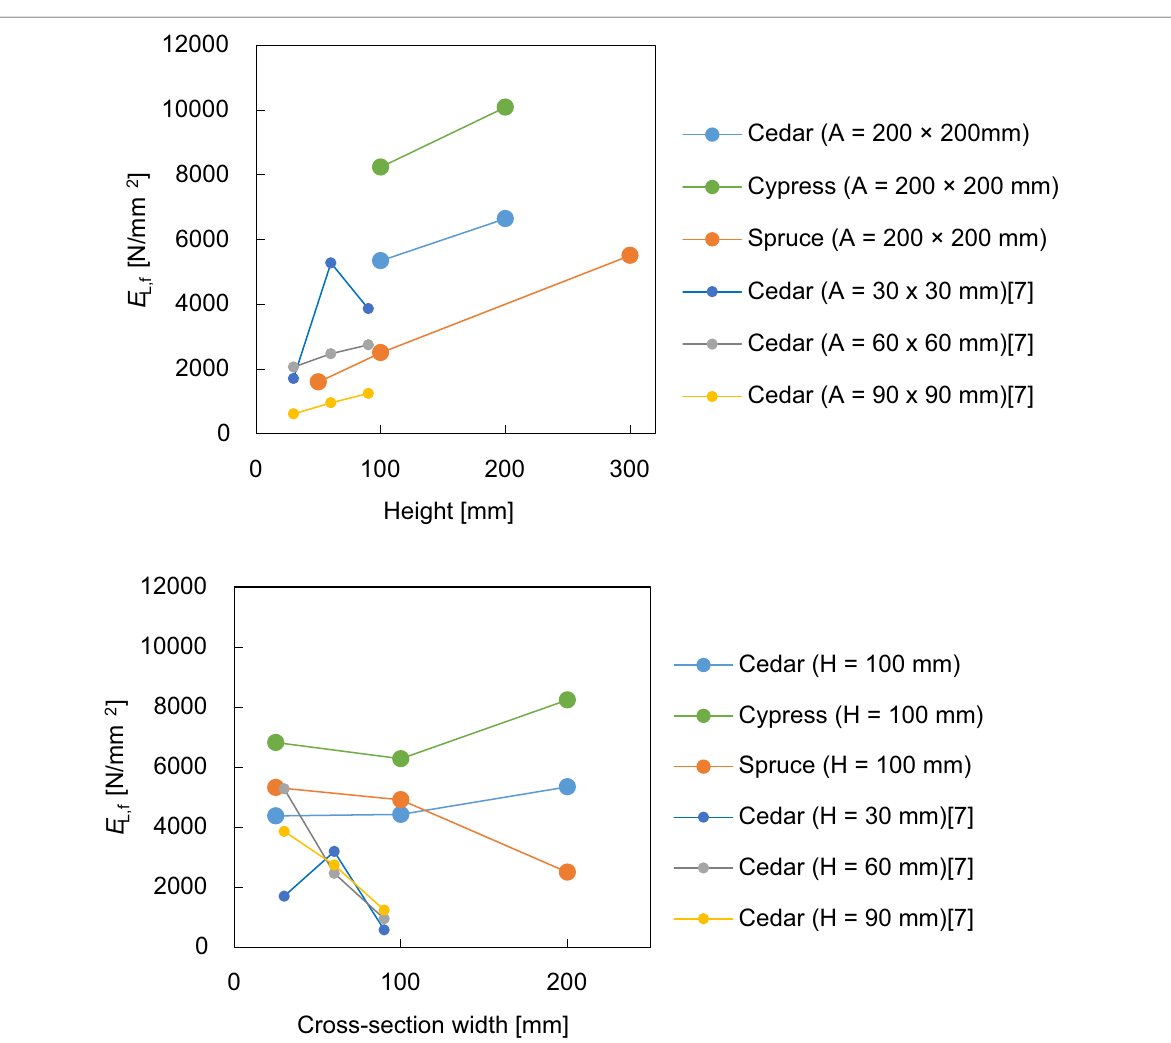
Fig. 8 Influence of heights and widths of cross-sectional area on values of E L,f